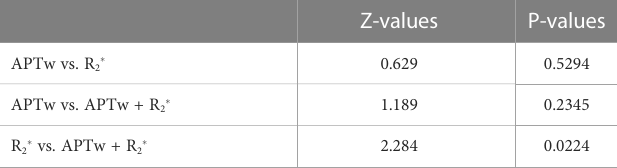
TABLE 6 Receiver operating characteristic curve paired with the Delong test.